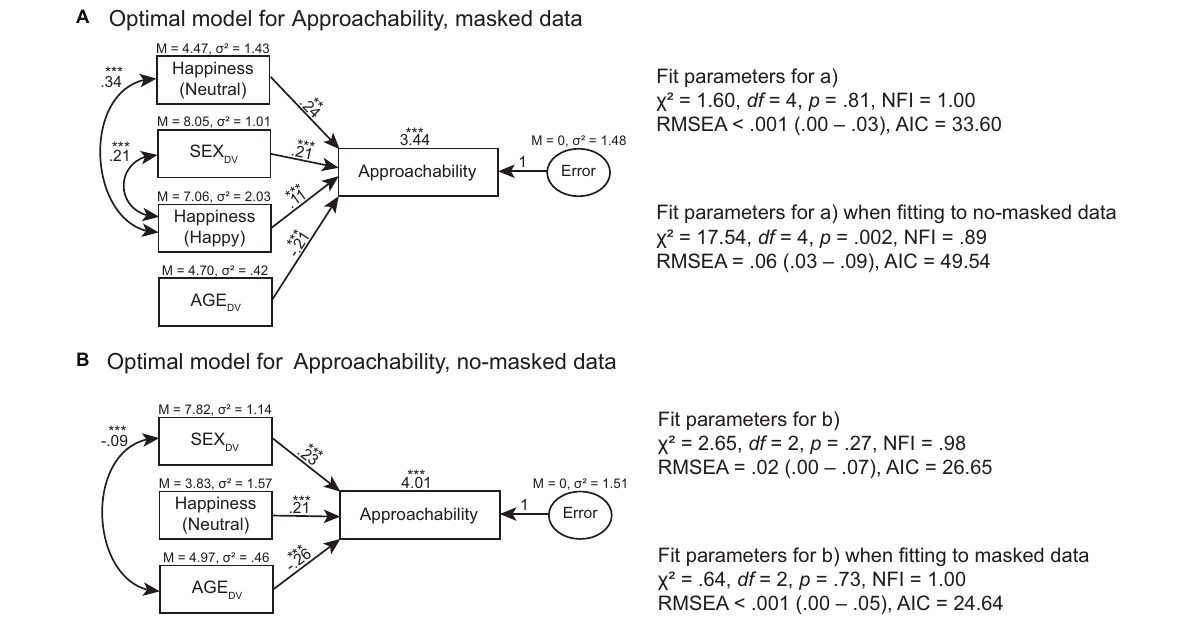
FIGURE 8 | Optimal models of Attractiveness for (A) masked face data and (B) no-masked face data. *** p > 0.001, ** p > 0.01, * p >